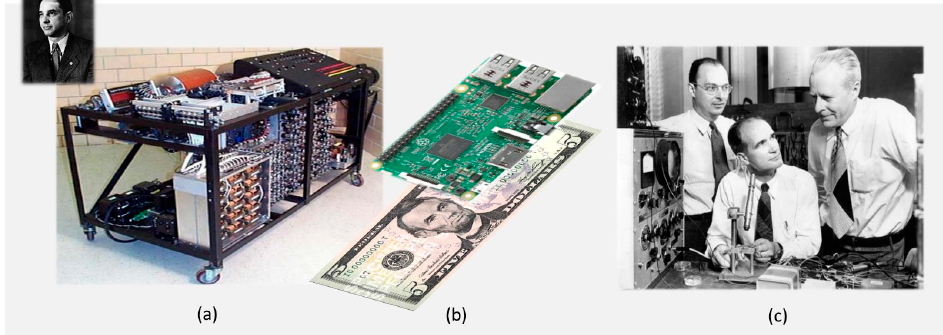
Figure 1. ( a ) Prof. J. Atanasoff (Iowa State College, 1938) and the replica of ABC (Museum